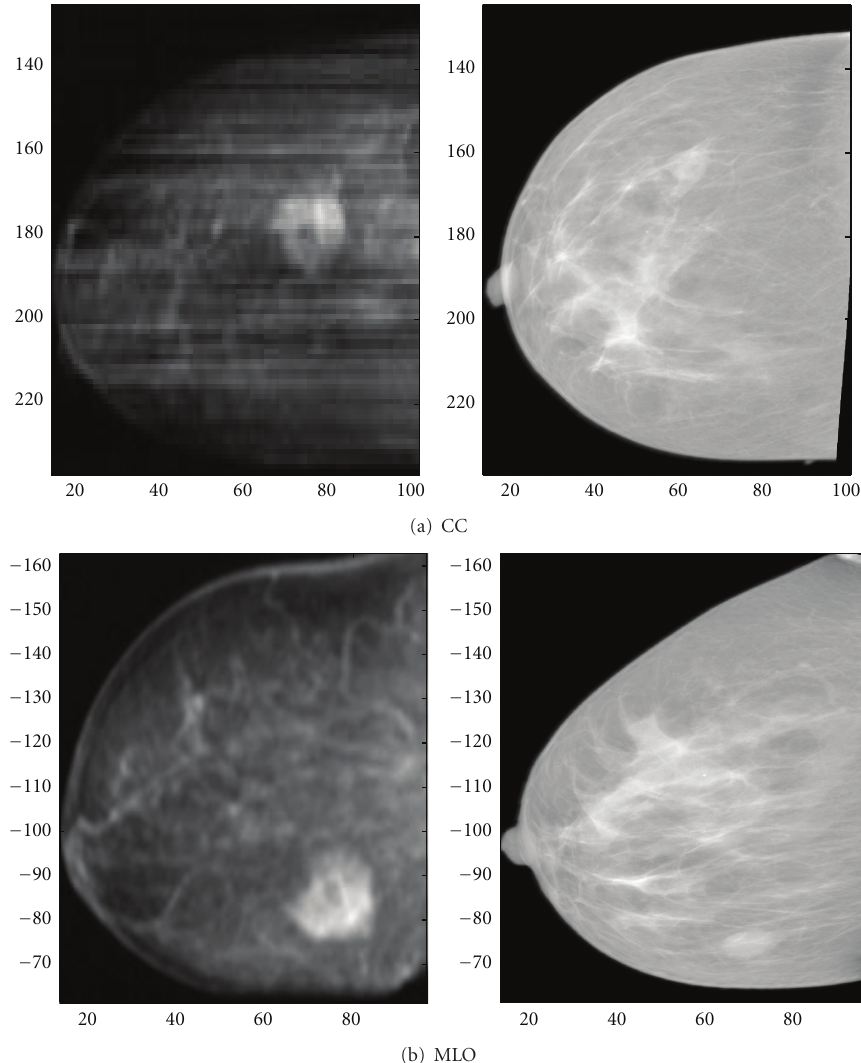
Figure 10: Comparison between contrast-enhanced MRPIs and registered mammograms of data set 100704-R. Corresponding lesions were indicated by a radiologist and are located to the right of centre in the CC images and on the lower right in the MLO